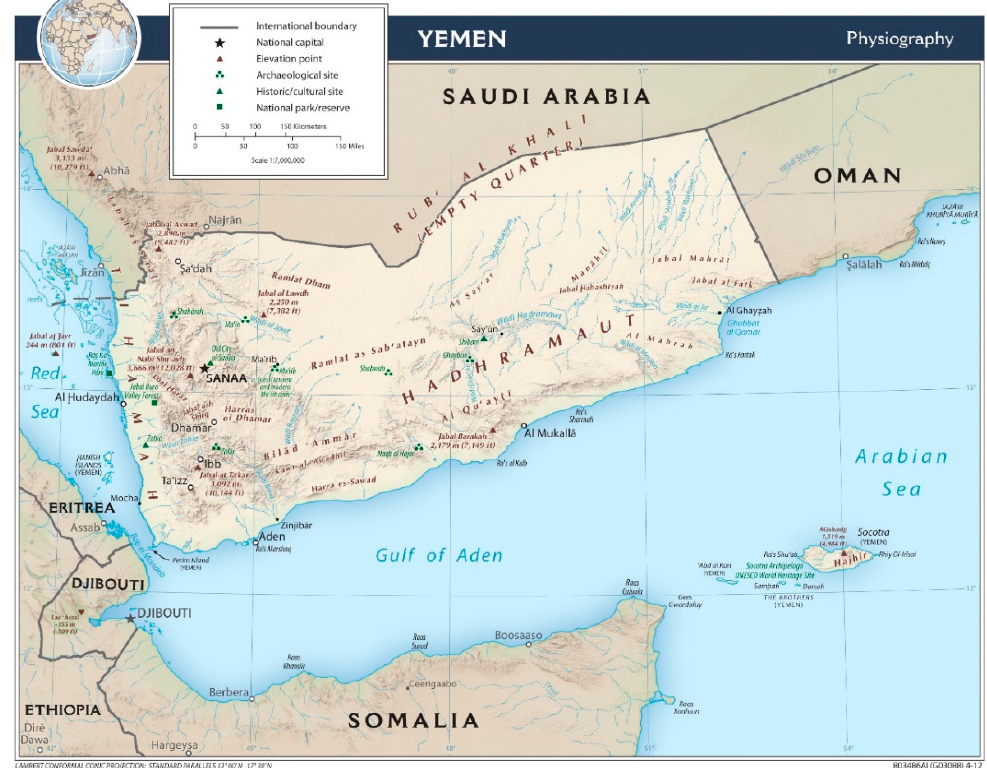
Figure 2. Map of Yemen (source: Public domain provided by United States Central Intelligence Agency‘s World Factbook).